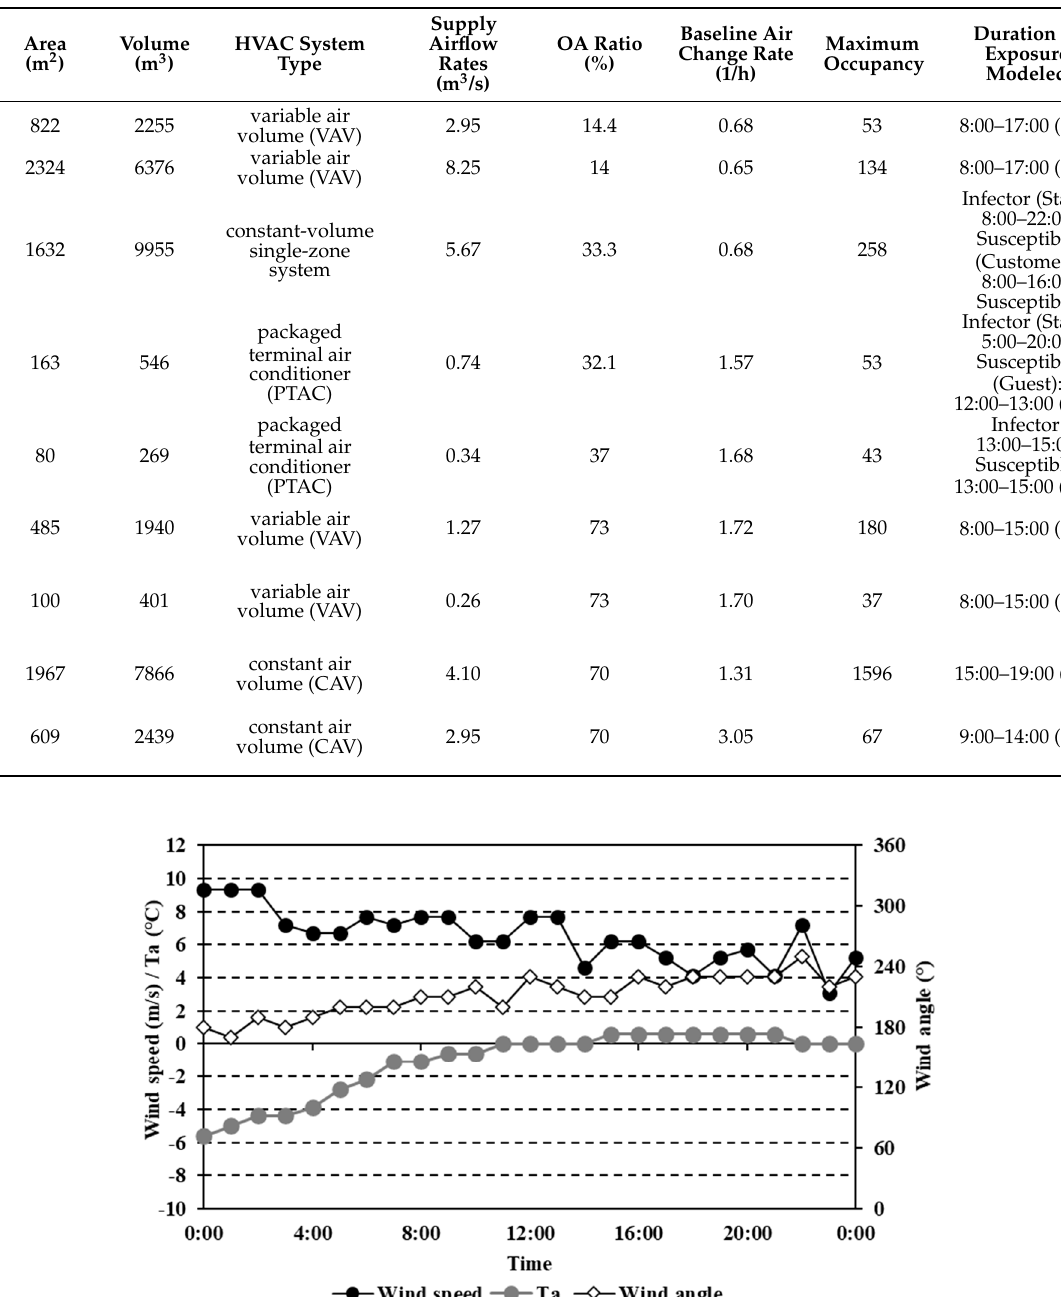
Table 2. SARS-CoV-2 Quanta-Related Modeling Parameters. Input